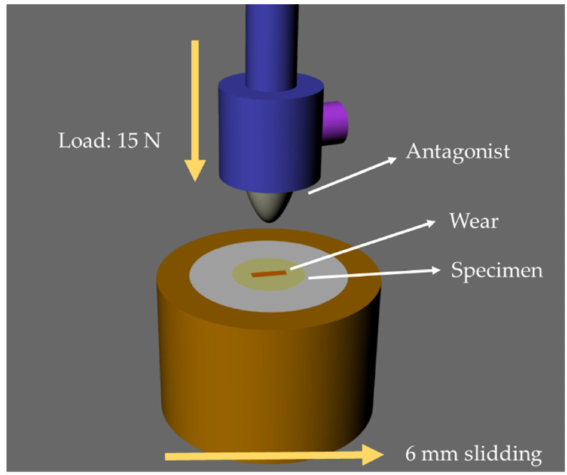
Figure 1. Descriptive illustration of the wear simulation test. The indenter reaches the specimen with a load of 15 N and slides 6 mm before returning to the initial